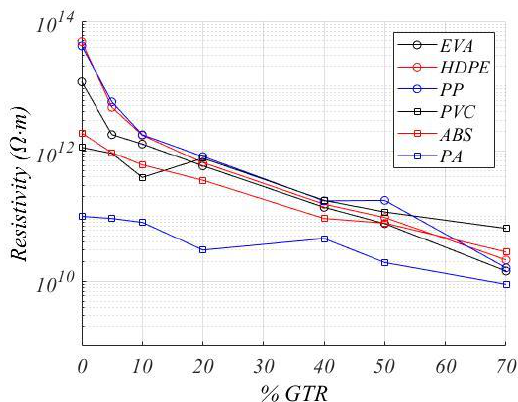
Figure 3. The electrical resistivity (Ω·cm), for different polymers/GTR contents with a particle size Figure 3. The electrical resistivity ( Ω · cm), for di ff erent polymers / GTR contents with a particle size < 200 µ m. The frequency was fixed at 50 Hz and 30 ◦ <200 µm. The frequency was fixed at 50 Hz and 30 °C.